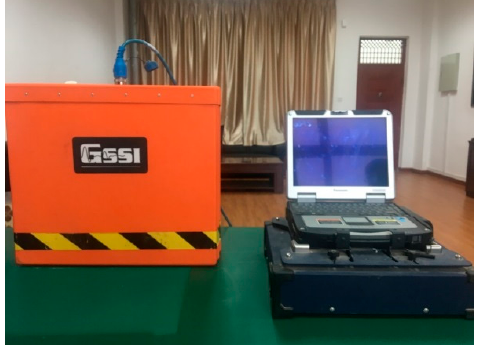
Table 2. Specific ten different types of human motion description.